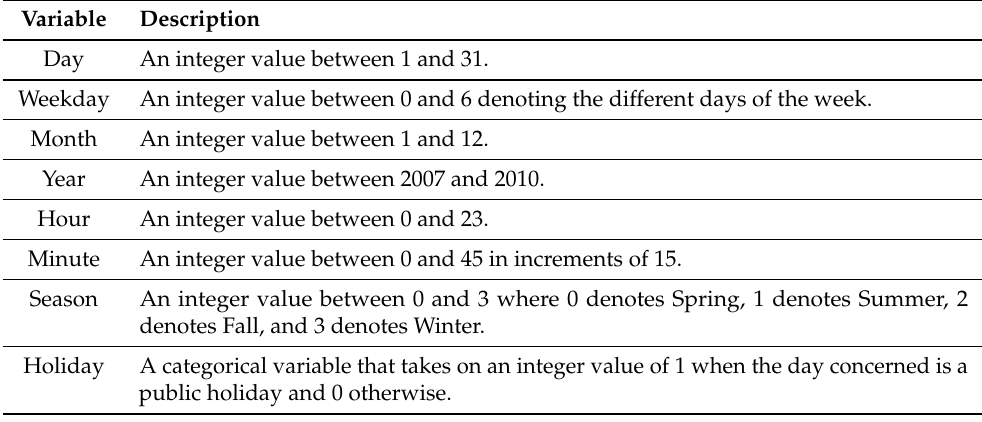
Table 2. List of temporal variables that were taken into consideration during the feature engineering process, as outlined in Section 4.3.